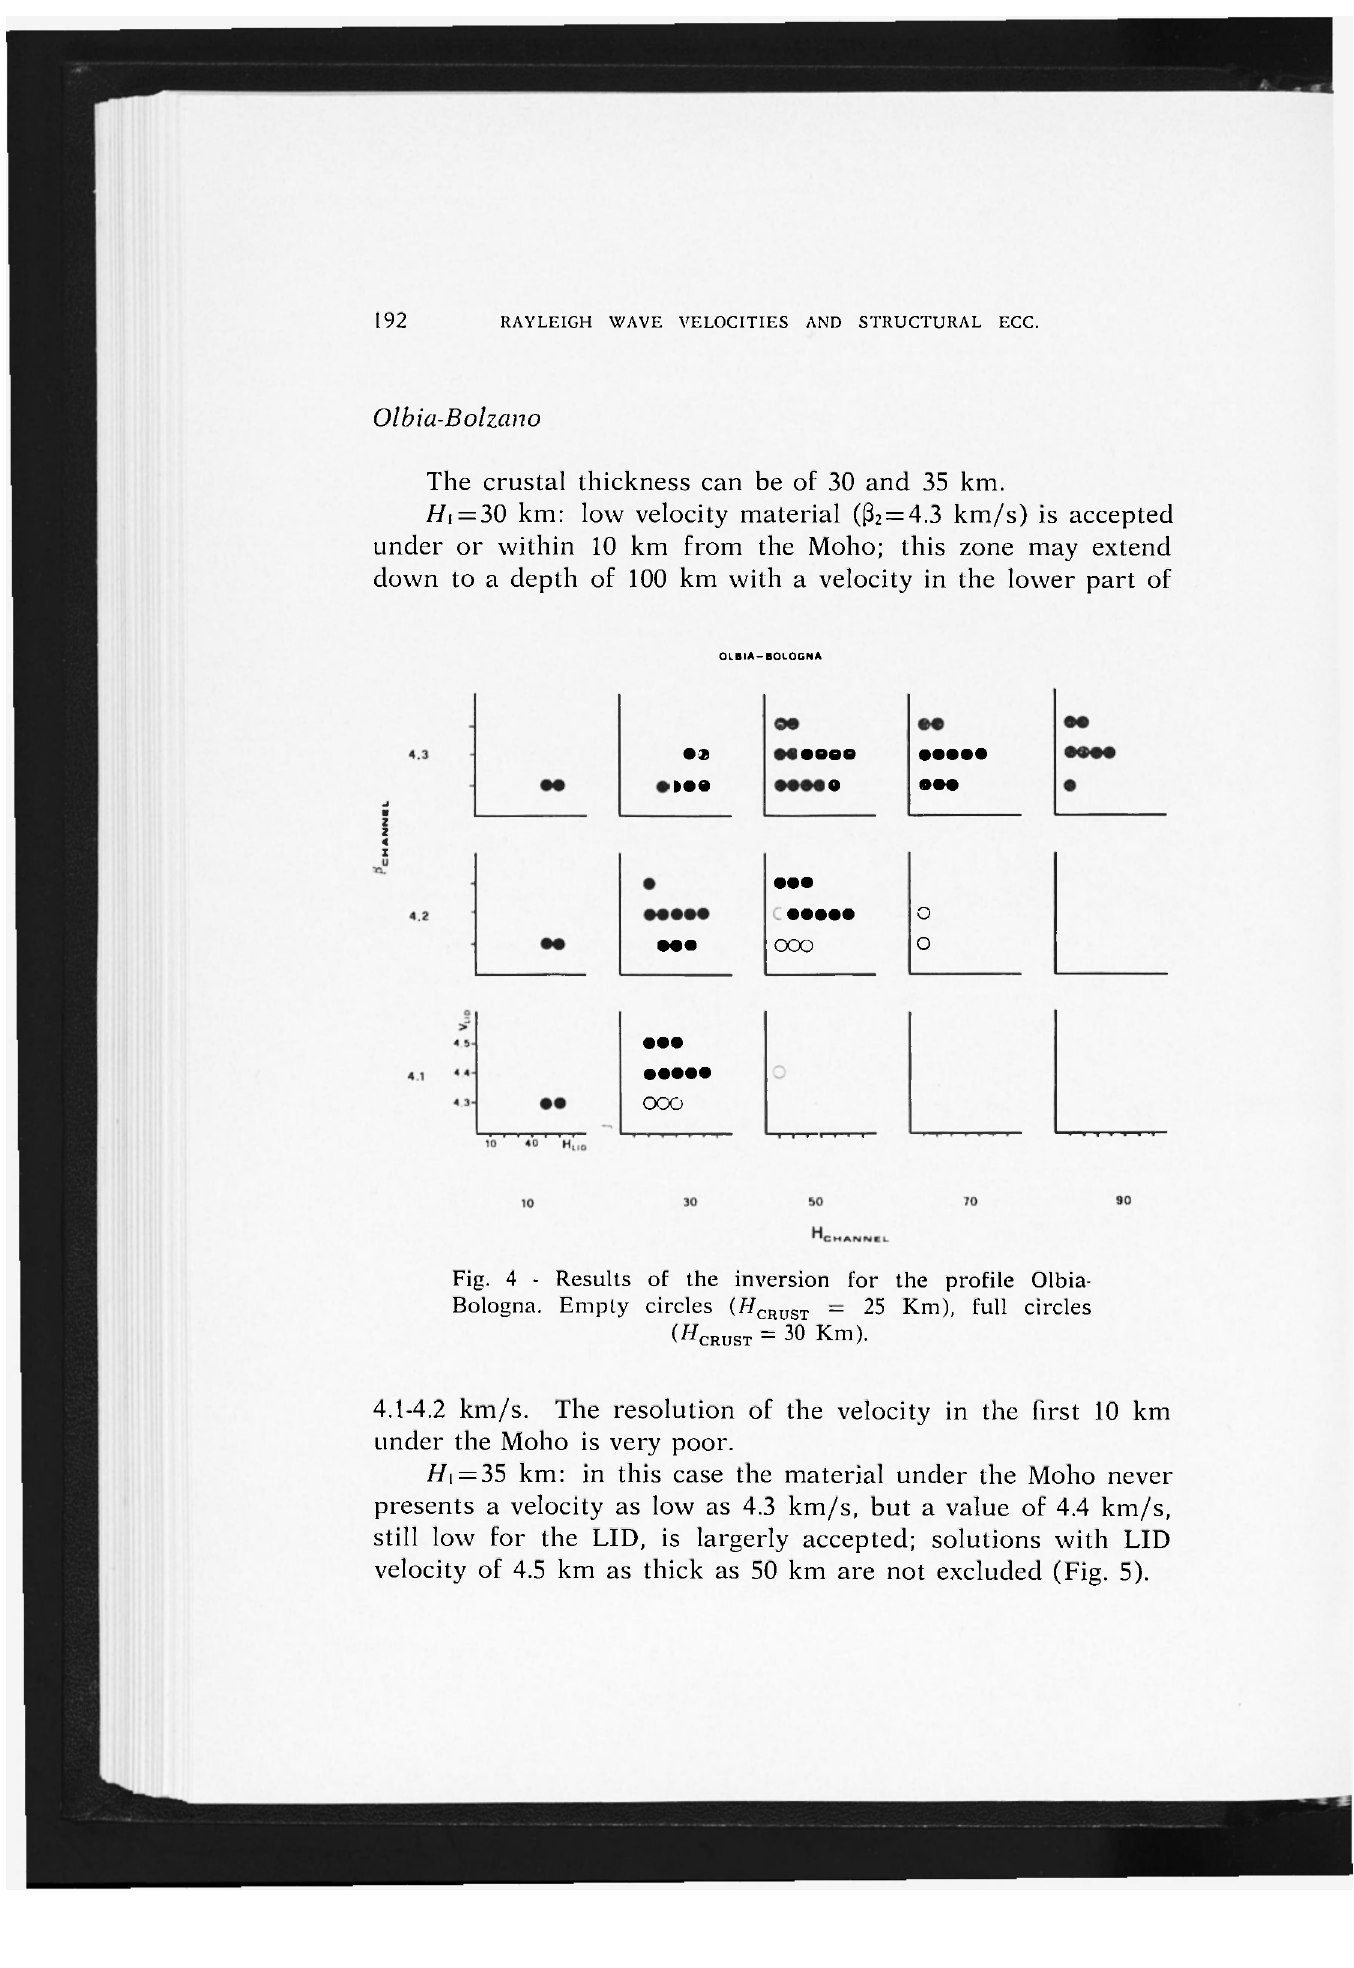
Fig. 4 - Results of the inversion for the profile Olbia- Bologna. Empty circles (H CRVST = 25 Km), full